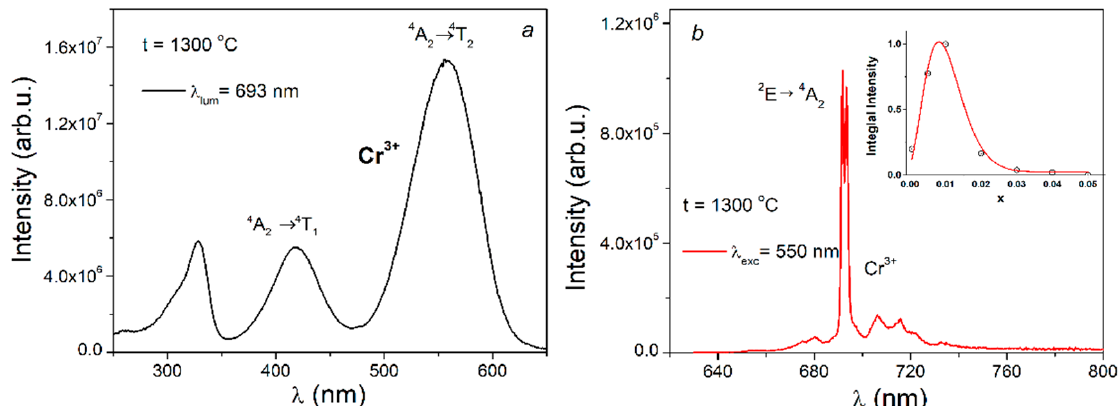
Figure 9. The luminescence excitation ( a ) and photoluminescence ( b ) spectra of Cr 3+ ions in SrAl 4 O 7 :0.0005Cr 3+ powders. The inset of ( b ) presents the concentration dependence of Cr 3+ integral photoluminescence.